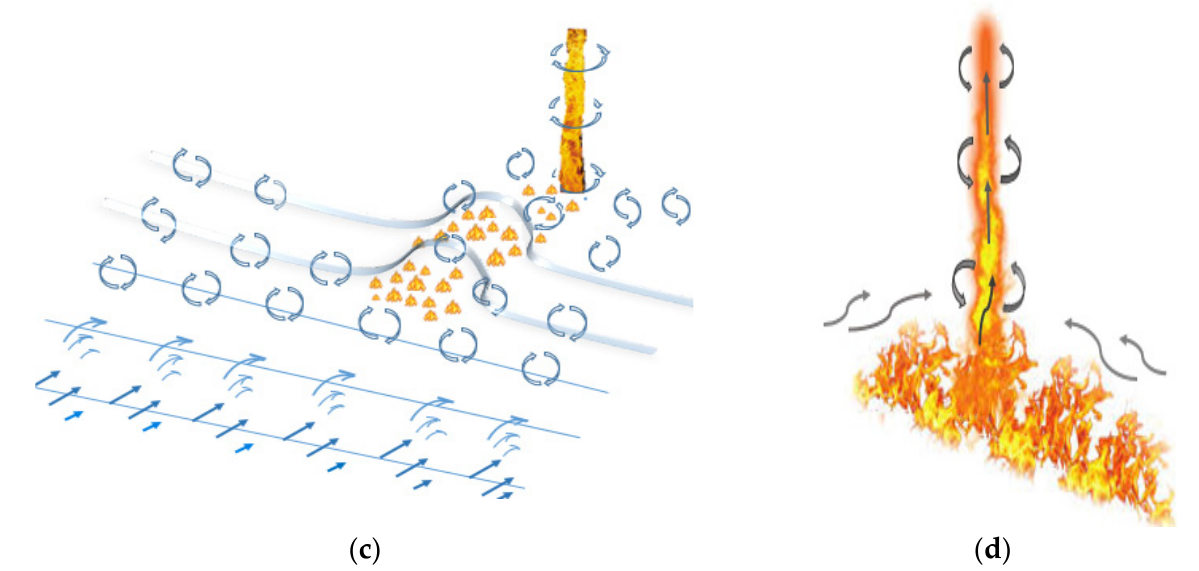
Figure 1. ( a ): Fire whirls in Australia 2012, photo courtesy of Chris Tangey; ( b ) Fire whirls from a 3-meter diameter pool in the Fire Laboratory for Accreditation of Modeling by Experiment, or FLAME, facility at Sandia National Laboratories; ( c ) The process of forming rotating columns of flame; ( d ) The laboratory fire whirl. Credit: Bryan Christie Design [12].